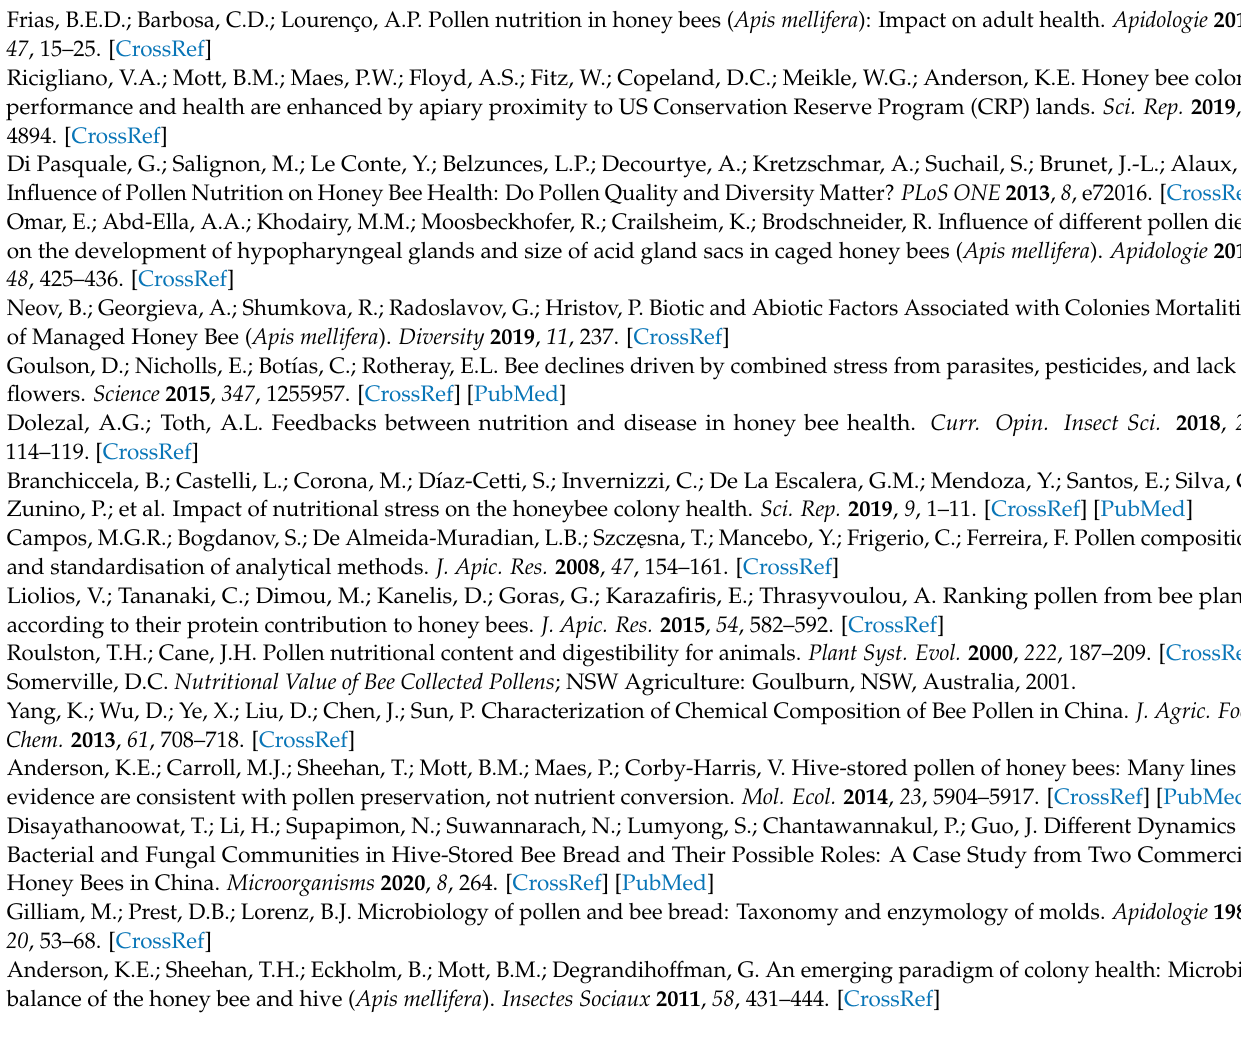
quantification. Table S2: Primers used for quantification of honey bee gene expression. Table S3: The information of the fungi isolated in this